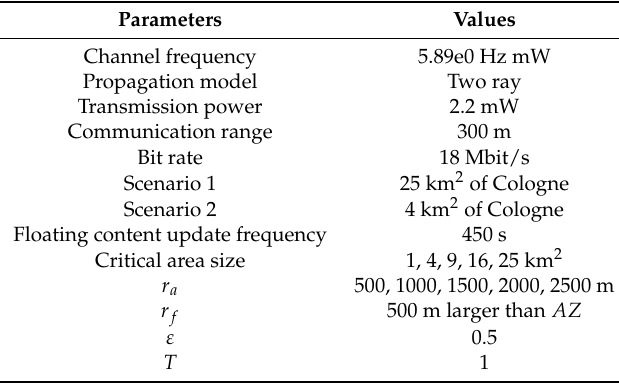
Table 4. Simulation